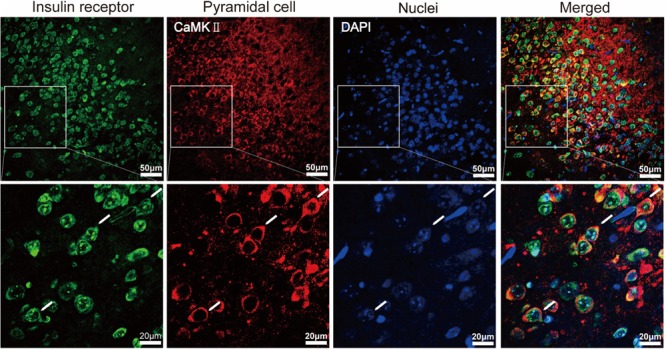
Immunohistochemical characterization of the expression of insulin receptors in pyramidal neurons of the APC. The (Bottom) shows the enlarged image of the areas within white boxes in the (Top). The white arrows indicate examples of pyramidal neurons (red) expressing insulin receptors (green).